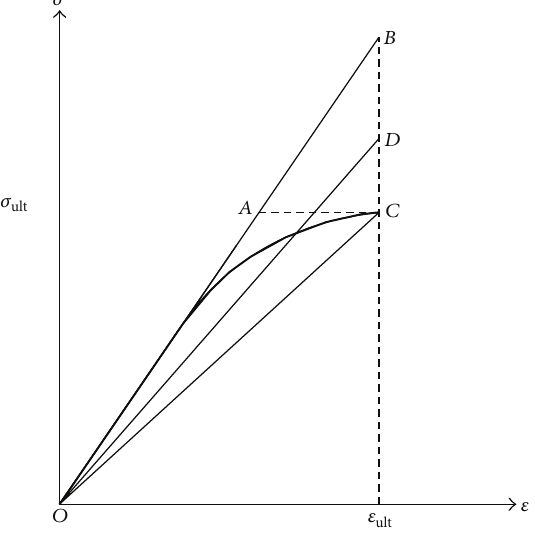
Figure 11: Different ways of linear approximation for nonlinear stress-strain relationship of polymer matrix or matrix dominant lamina